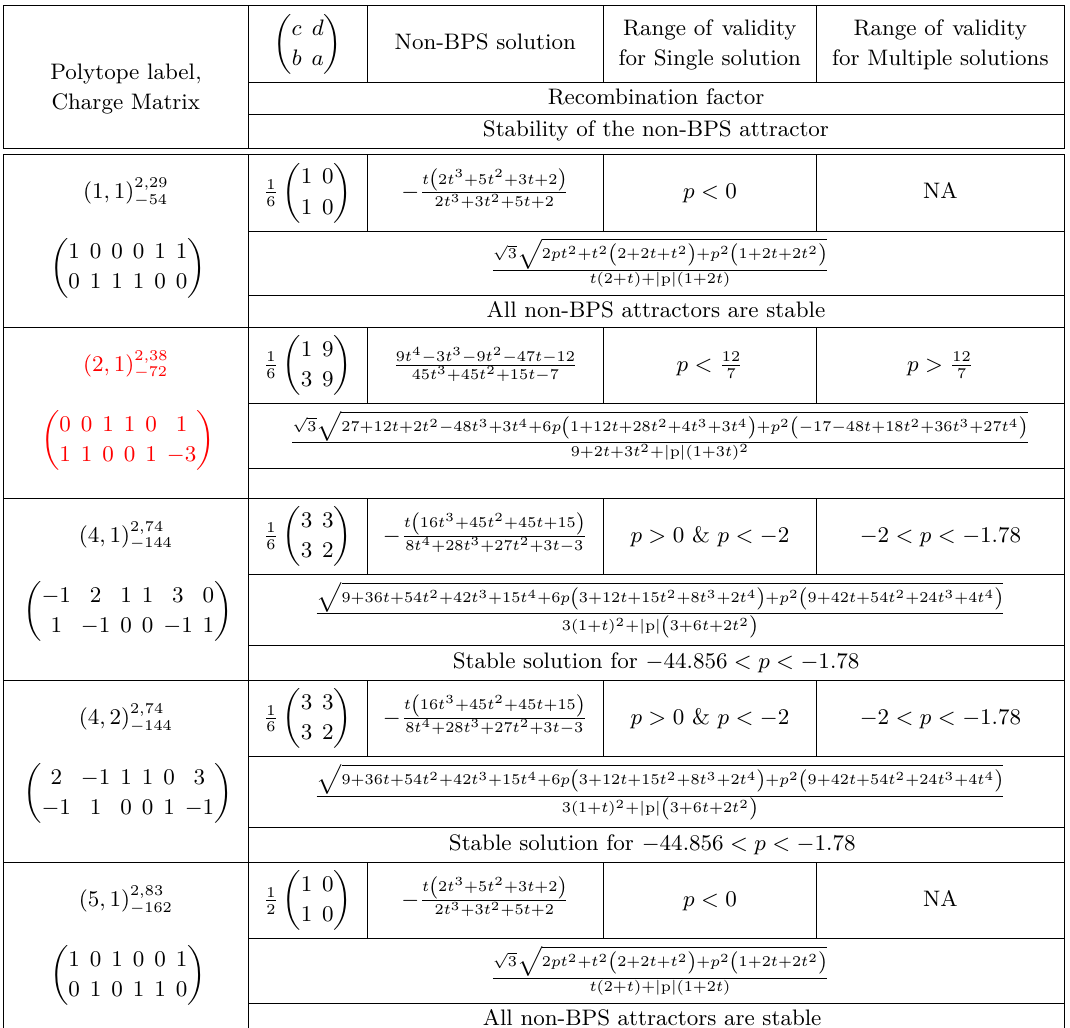
Table 12 . Non-BPS extremal (multiple) black strings in one-modulus THCY models,